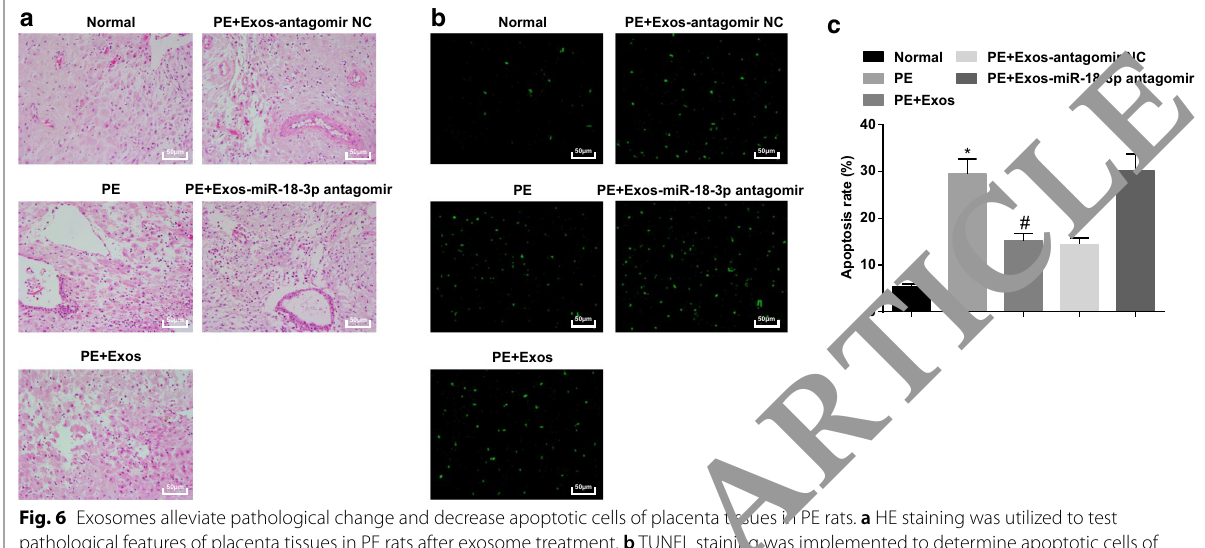
Fig. 6 Exosomes alleviate pathological change and decrease apoptotic cells of placenta tissues in PE rats. a HE staining was utilized to test pathological features of placenta tissues in PE rats after exosome treatment. b TUNEL staining was implemented to determine apoptotic cells of placenta tissues in PE rats after exosome treatment. c Cell apoptosis rate was detected by TUNEL staining. n 10, * p < 0.05 versus the normal group. = # p < 0.05 versus the PE group. $ p < 0.05 versus the PE Exos-antagomir NC group. Measurement data were depicted as mean standard deviation, + ± and comparisons among multiple groups were assessed by one-way ANOVA followed by Tukey’s